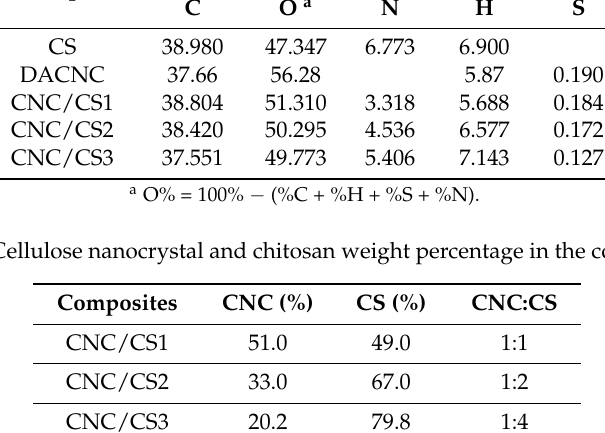
Table 2. Cellulose nanocrystal and chitosan weight percentage in the composites.